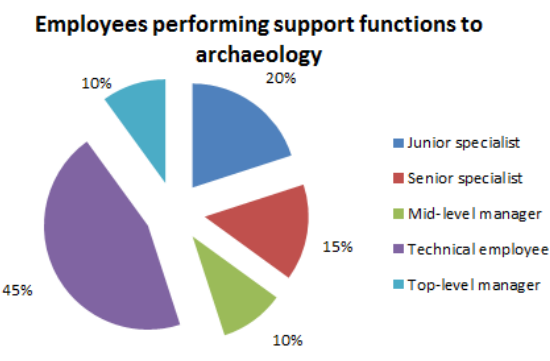
Figure 10 - Support functions to